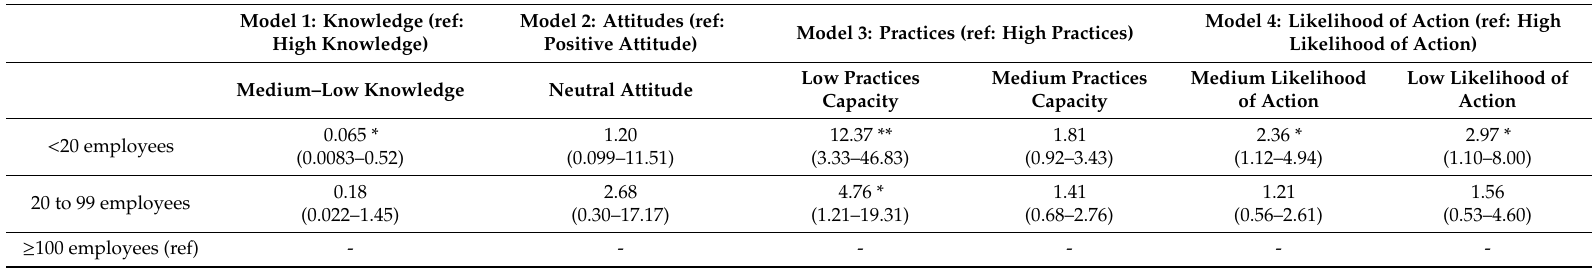
Figure 5. Percent Likelihood of Class Assignment Based on A ffi rmative Response to Eight WHP Likelihood of Action Items ( n = 528). Table 2. Estimated Odds Ratio from a Multinomial Logistic Regression of Membership in Latent Classes of WHP Knowledge, Attitudes, Practices, and Likelihood of Action on Organization Size (n = 528).